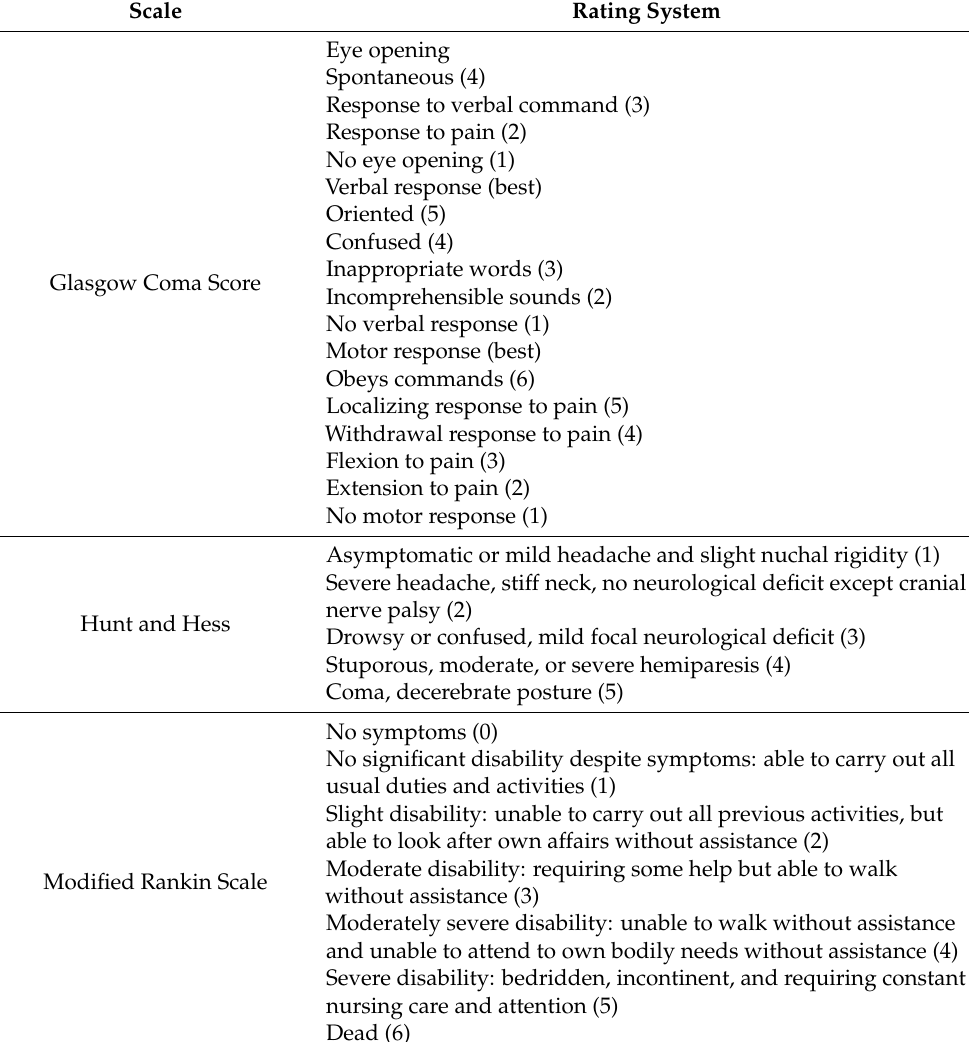
Table 3. Selected rating scales